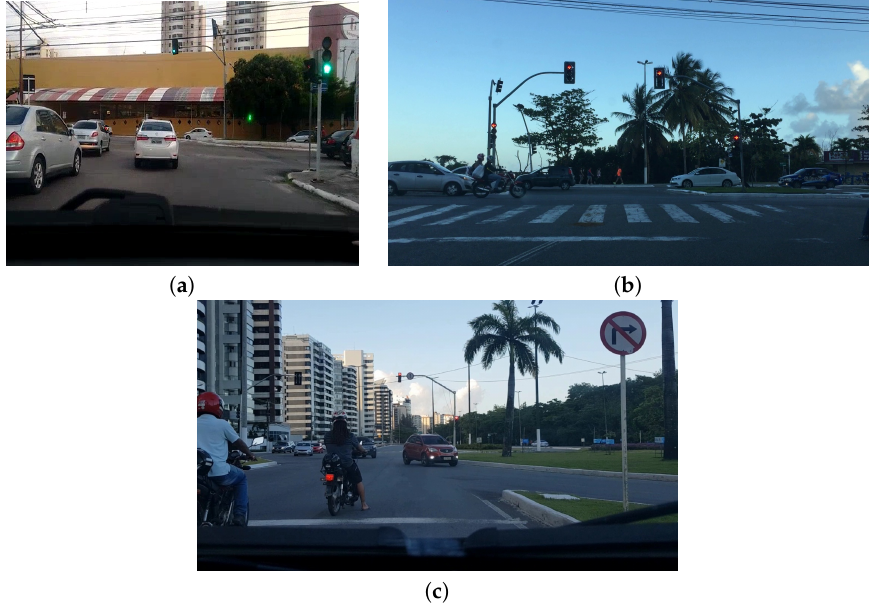
Figure 2. Images obtained using the TLR device support prototype with different smartphones. From top to bottom (left to right): ( a ) Motorola G 2nd Generation; ( b ) iPhone 6; and ( c ) Galaxy